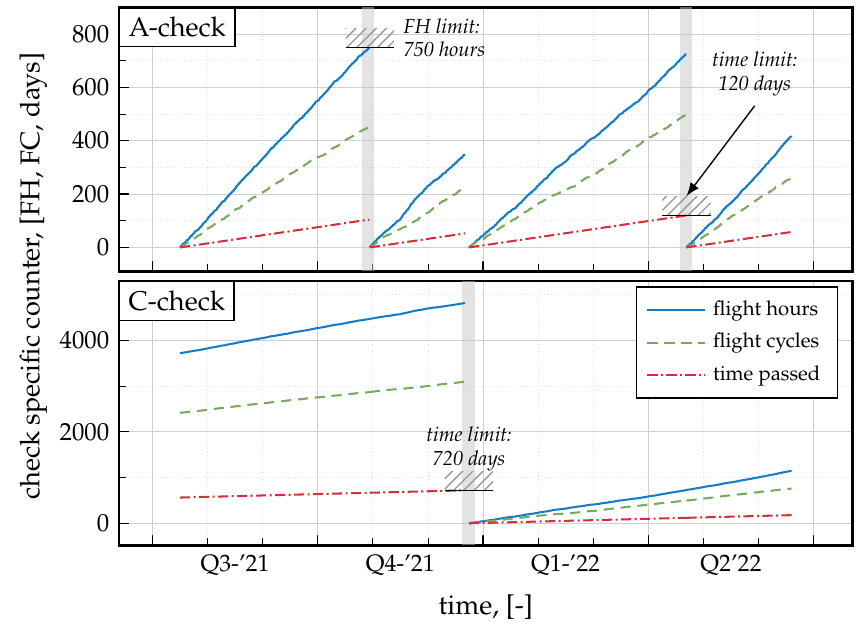
Figure 10. The monitoring and triggering process shown for the A-check and